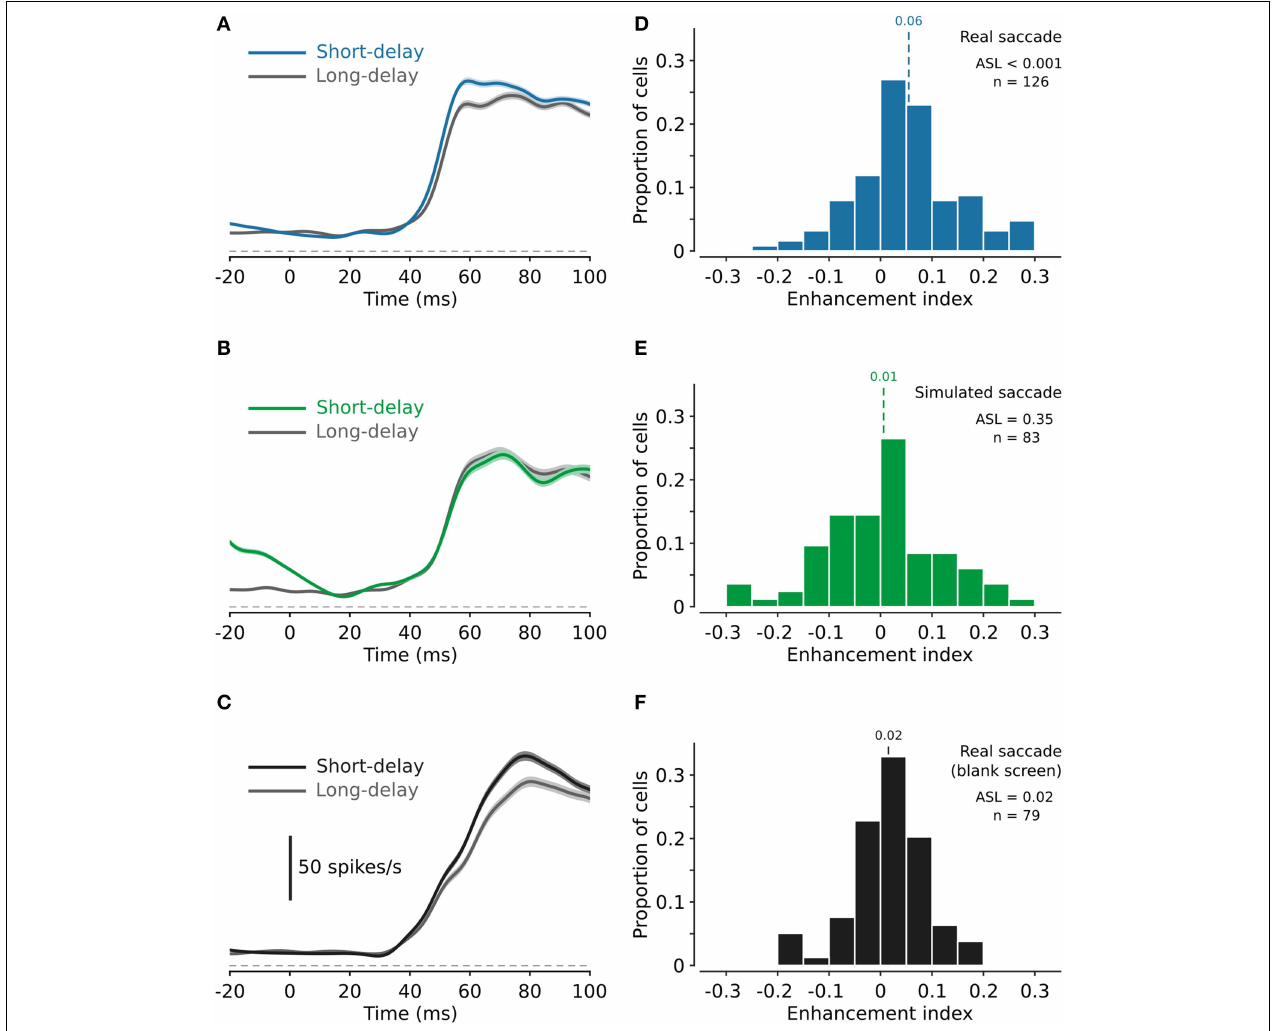
FIGURE 3 | Enhancement of neural responses after real and simulated saccades, and the effect of peri-saccadic stimulus contrast. (A,B) Neural responses for test stimuli presented after real and simulated saccades, respectively, averaged across all cells. Responses are enhanced after real saccades (A) but not after simulated saccades (B) . (C) Neural responses for test stimuli presented after real saccades made across a blank screen (i.e., contrast of the background texture during the peri-saccadic period was 0%). As for responses following saccades across the high contrast background texture, neural responses for this paradigm are on average greater in the short-delay condition compared to the long-delay condition. (D,E) Histograms of the neural enhancement index, for all cells, for test stimuli presented after real and simulated saccades, respectively. On average, responses are significantly enhanced after real saccades [ (D)